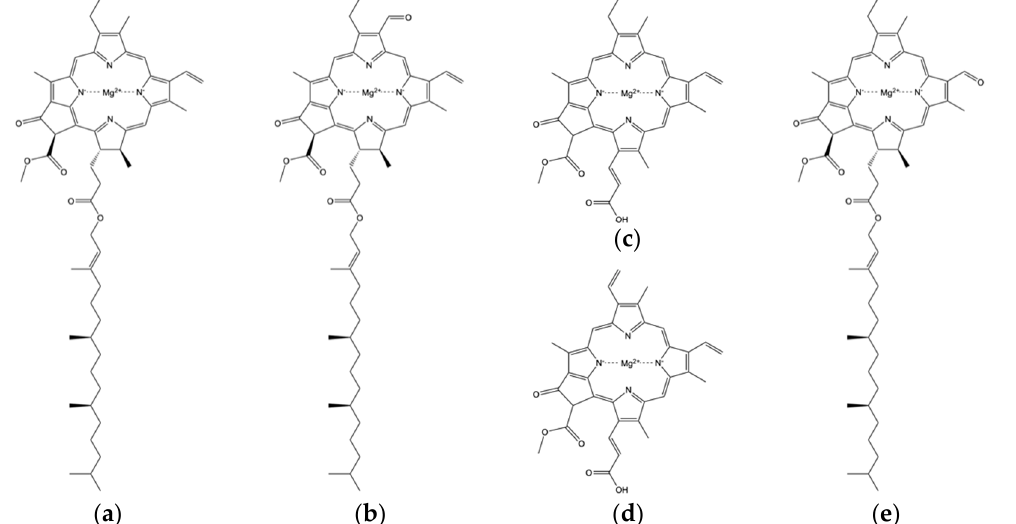
Figure 1. The chemical structure of the chlorophylls present in marine algae: ( a ) Chlorophyll a ; ( b ) Chlorophyll b ; ( c ) Chlorophyll c1 ; ( d ) Chlorophyll c2 ; ( e ) Chlorophyll d .